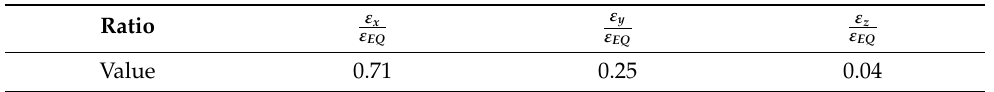
Figure 5. Time series of VD obtained by linear regression (light curve) and VD obtained by IDM (black) for the longest bora episode and at ( a ) 16 m, ( b ) 25 m and ( c ) 31 m mid − levels. The square of the correlation coefficients are r 2 = 0.97 at 16 and 25 m and r 2 = 0.95 at 31 m mid − levels. Table 1. Means of the ratios between VD components and its total. The ratios are calculated for all bora episodes and all mid −